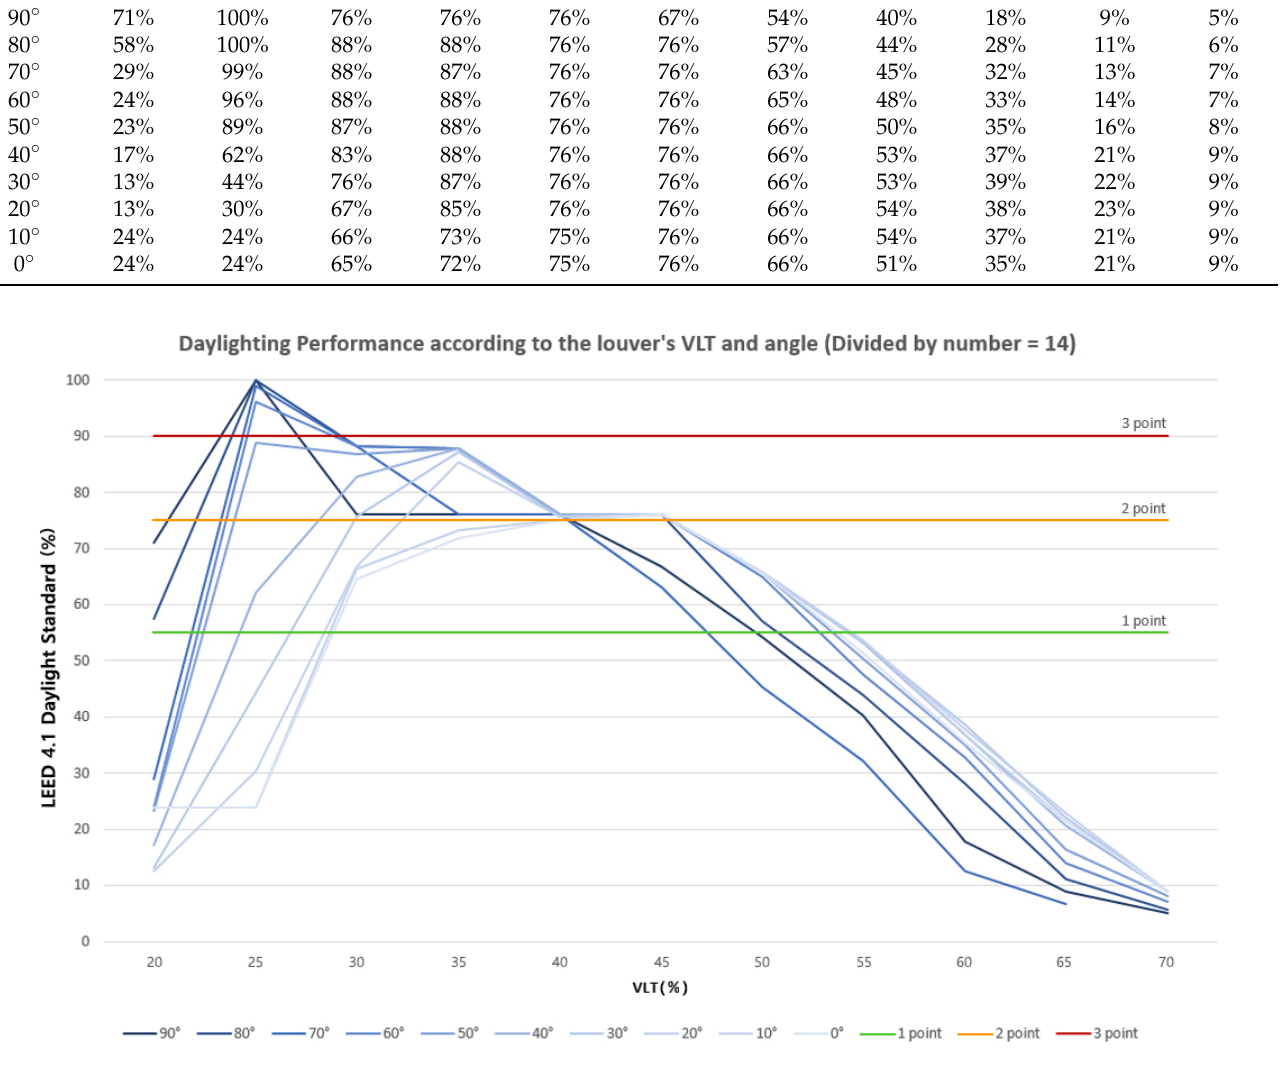
Table 9. Target illuminance achievement rates when the number of divisions of louvers is 15.